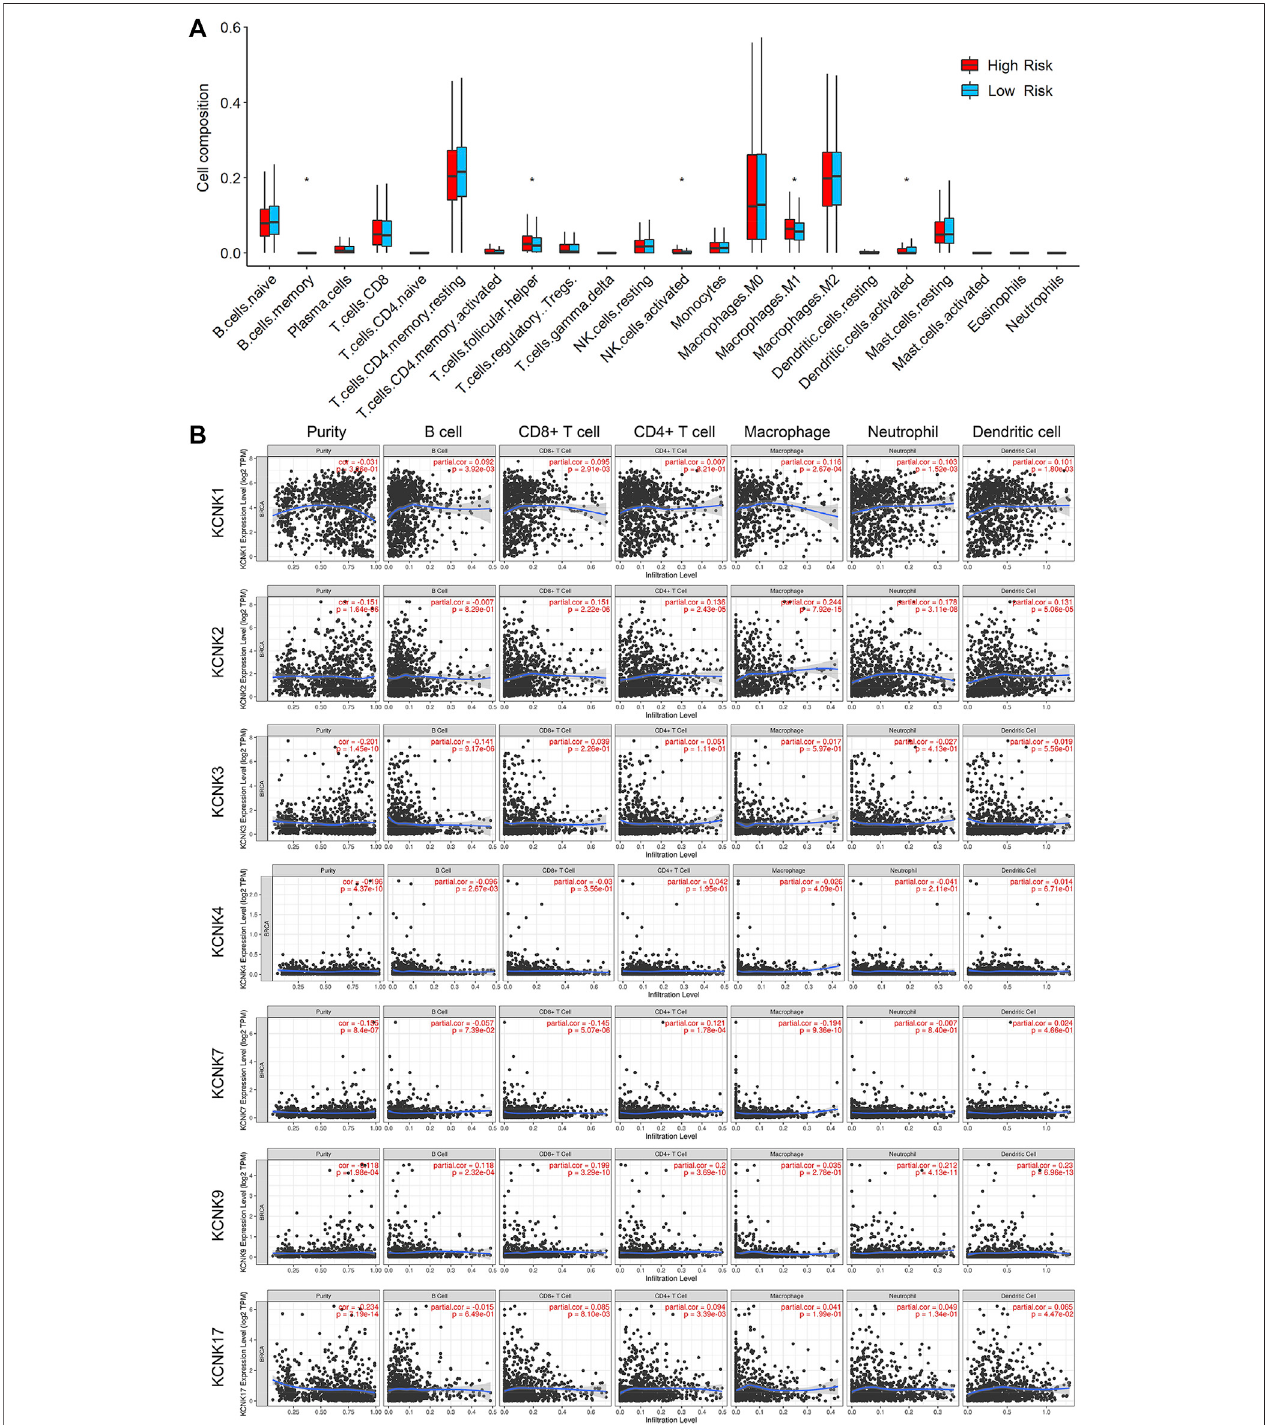
FIGURE 7 | Relationship between KCNK-based risk model and tumor microenvironment components in breast cancer. (A) Boxplots of the in fi ltrated level of immuneorstromalcellsinthetumormicroenvironmentbetweenhigh-andlow-riskgroupsaccordingtotheTCGAcohorts. (B) Thecorrelationbetweensevenmodeling KCNK genes and the in fi ltrated level of immune or stromal cells in the tumor microenvironment.